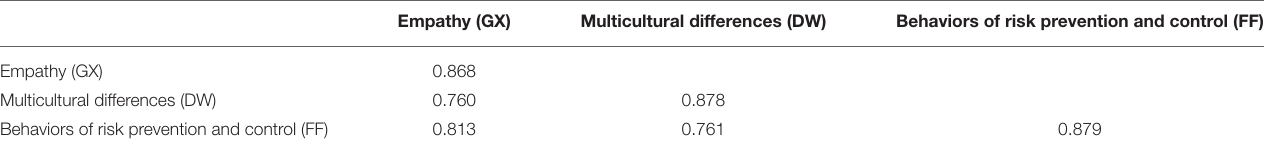
TABLE 5 | Correlation coefficient matrix between latent